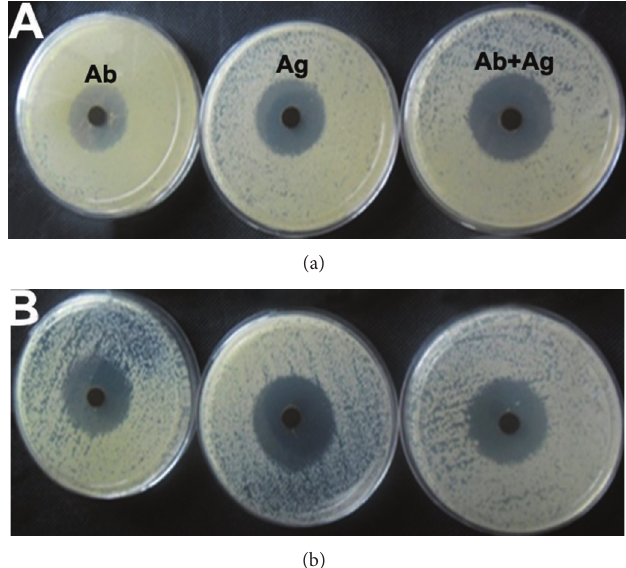
Figure 9: Antibacterial activity of silver nanoparticles synthesized by using leaf and stem extract of Piper nigrum.